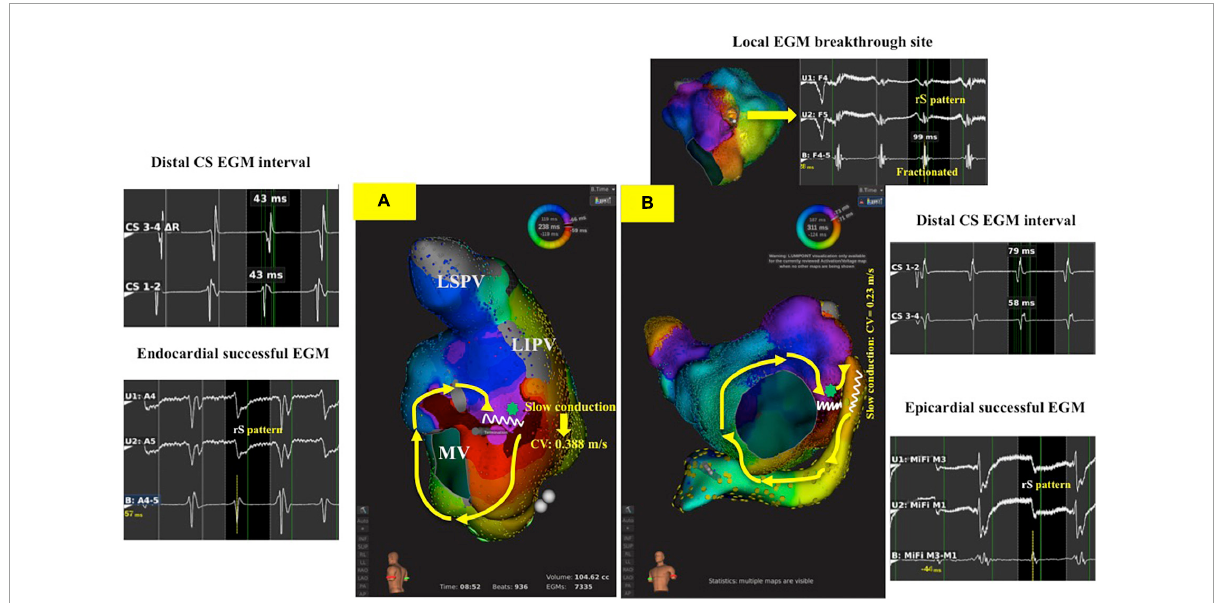
FIGURE2 3-D activation map during perimitral AFL in endocardial and epicardial successful ablation groups. (A) : A patient with CW perimitral AFL and the AFL was successfully termination during posterolateral mitral line ablation with bidirectional block of mitral line (Group 1 patient). The interval of distal CS EGM was 43 ms, and the unipolar signal in endocardial successful site was rS pattern. The slowest conduction at endocardial success site (green star) in posterolateral mitral line was 0.388 m/s. (B) : A patient with CW perimitral AFL and the AFL was successfully termination during inside CS ablation with bidirectional block of mitral line following unsuccessful posterolateral mitral line ablation (Group 2 patient). The interval of CS 1-2 EGM was 79 ms, and the unipolar signal in epicardial successful site was rS pattern. The slowest conduction at epicardial success site (red arrow) in posterolateral mitral line was 0.23 m/s. The green star was focal breakthrough at posterolateral mitral line opposing to epicardial successful site showing fractionated EGM in bipolar and rS pattern in unipolar signal. AFL, atrial flutter; CS, coronary sinus; CW, counterclockwise; EGM, electrogram.